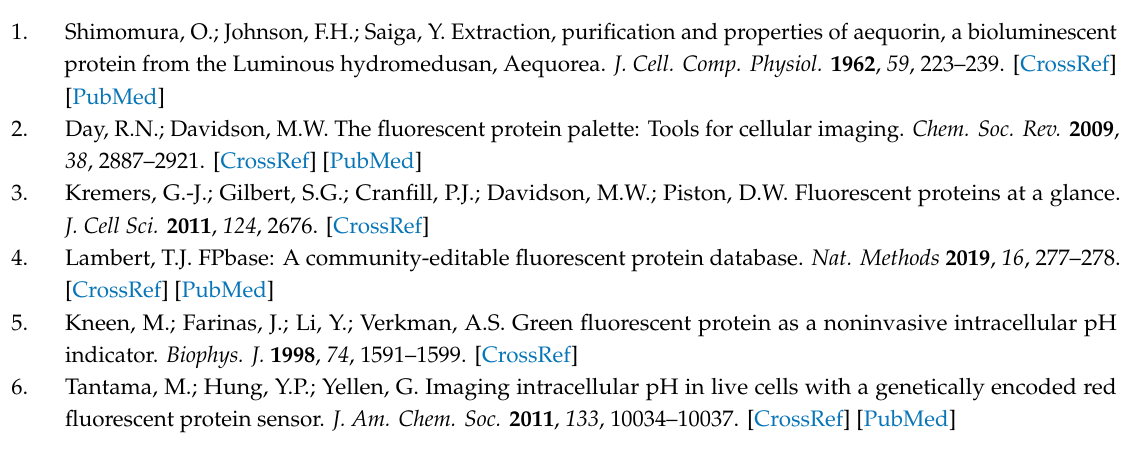
Figure S1. SDS-PAGE of soluble fractions after cell disruption by sonication, Figure S2. X-ray of the tertiary structure of sGFP, Figure S3. SDS-PAGE of the elution of His-RFP from rGOe, Figure S4. Selective of immobilization of Cys-sGFP and His-RFP on Purolite ® and TALON ® , respectively, Figure S5. Selective co-immobilization of Cys-sGFP and His-RFP on AG-Co2 +/ S, Figure S6. Selective of immobilization of Lys-sGFP on